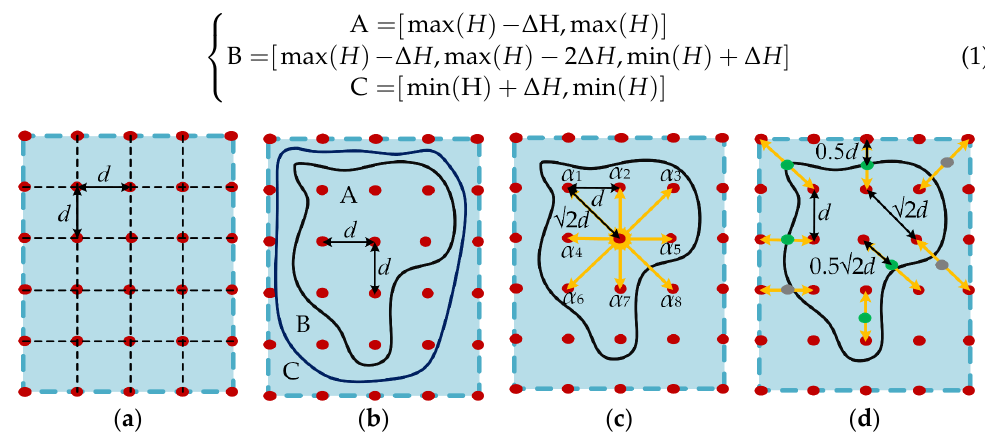
Figure 1. Schematic diagram of measurement method based on near-field distribution characteristics ( a ) Sparse uniform sampling; ( b ) Divide areas according to magnetic field intensity; ( c ) Calculate the magnetic field change for each point in region A. α q is shown in Equation (1).; ( d ) Additional measurement. d , √ 2 d , and 0.5 √ 2 d are the distances between the corresponding two points. In Equation (1), ∆ H = [max( H ) − min( H )]/4. H represents the intensity of the